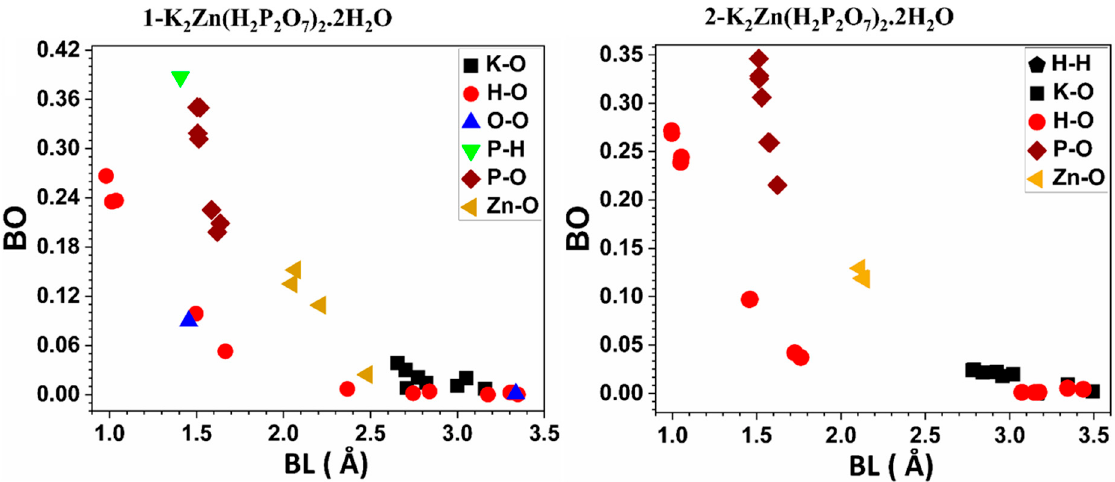
Figure 2. Distribution of calculated BO vs. BL for 1 and 2 crystals.